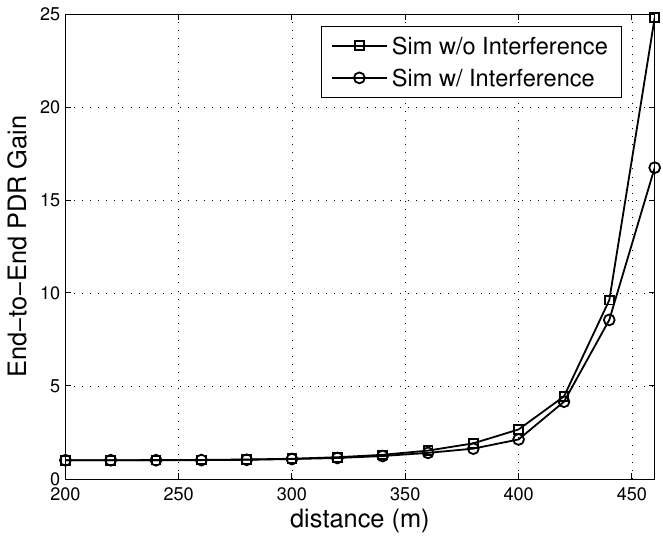
Figure 6. End-to-end PDR gain by using a robotic